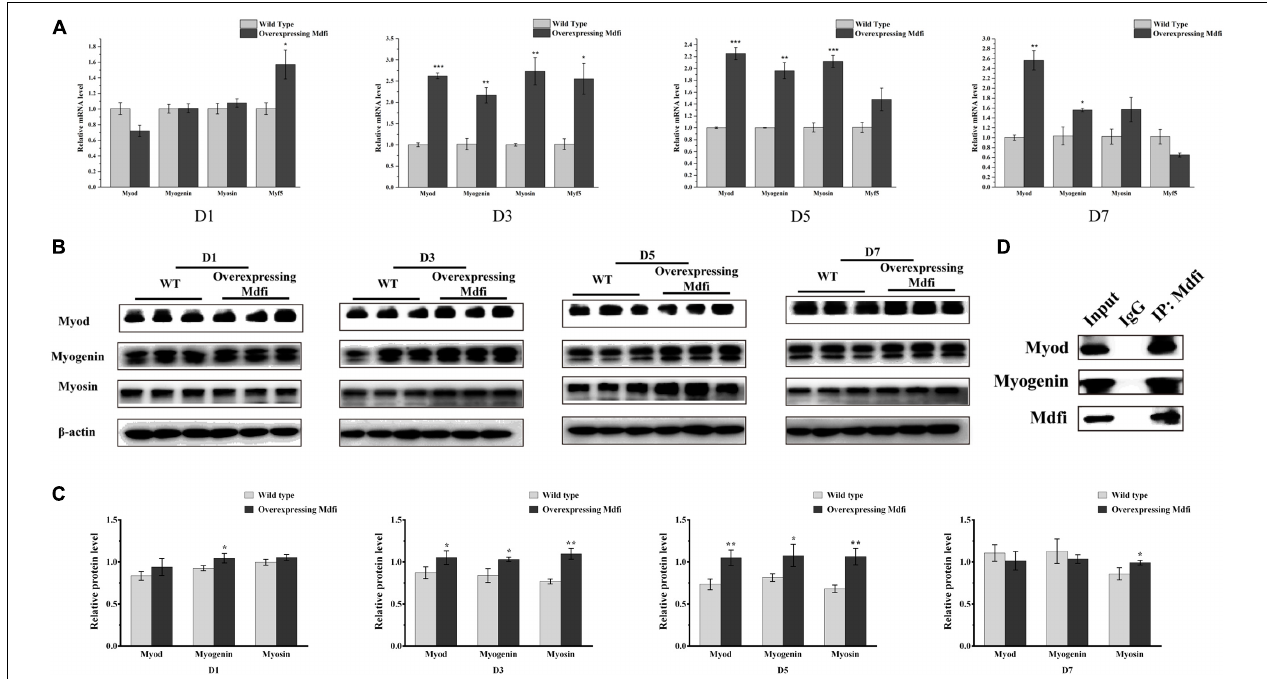
FIGURE 5 | Mdfi promotes the differentiation of C2C12 cells. (A) qPCR detection of myogenic marker genes on days 1, 3, 5, and 7 in both WT and Mdfi-OE C2C12 cells. (B) Western blot identified the protein of myogenic marker genes on days 1, 3, 5, and 7 after differentiation induction in both WT and Mdfi-OE C2C12 cells. (C) The relative protein levels were obtained through Western blot band gray scanning analysis. (D) Co-IP identified the interaction of Mdfi with Myod and Myog, respectively. *p < 0.05; **p < 0.01; *** p < 0.001. The results are presented as Mean ± SEM of three replicates for each